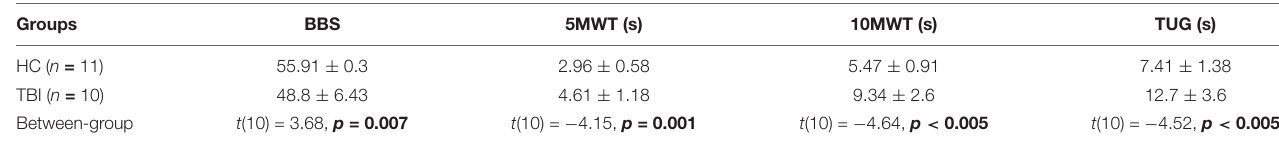
TABLE 3 | Between-group comparison of the functional outcome measures (mean ± sd) of static and dynamic balance.